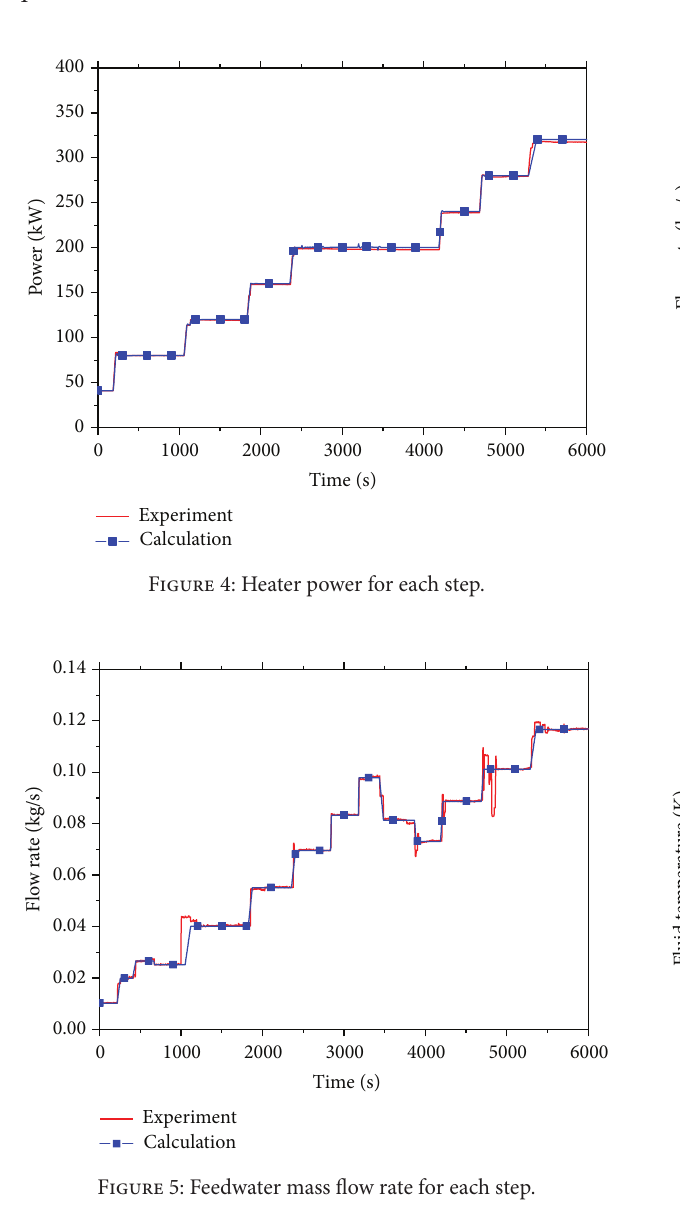
Figure 7: Fluid temperatures at the core inlet and